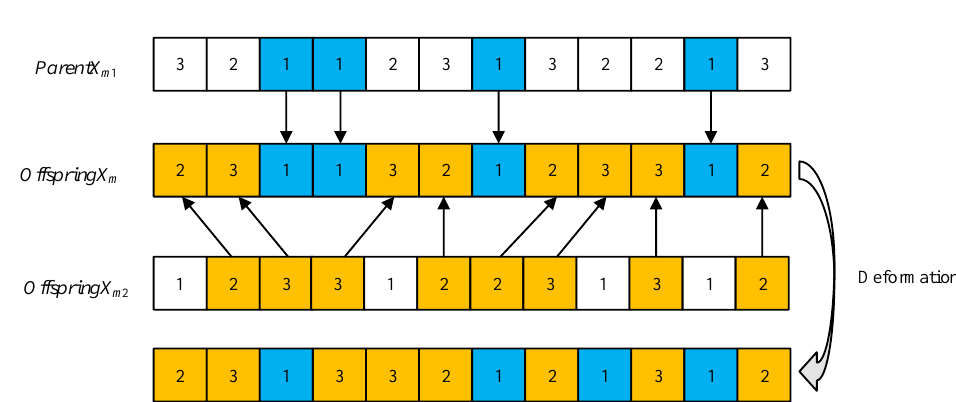
Figure 4. Process level update.